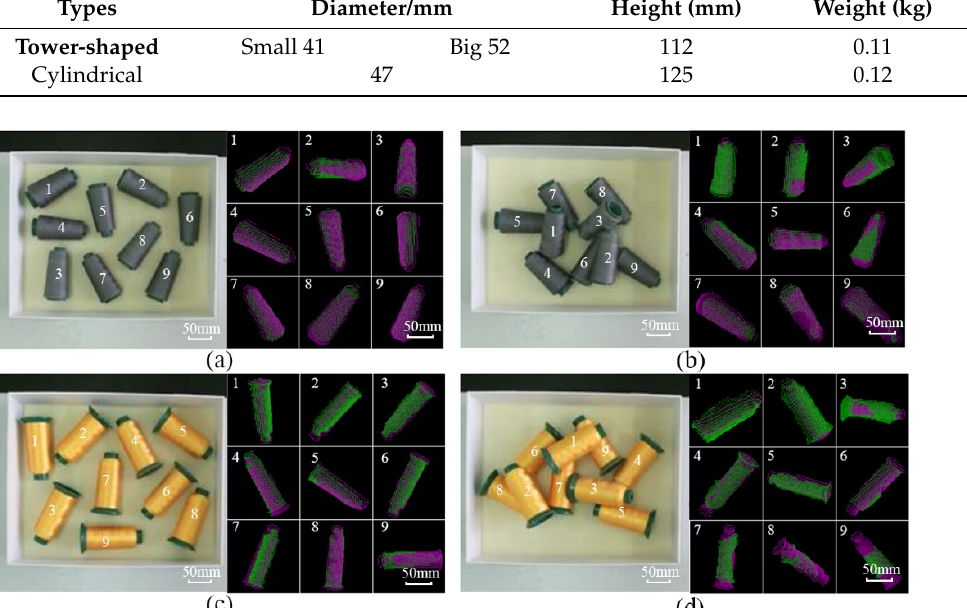
Table 2. Yarn bobbin specifications.